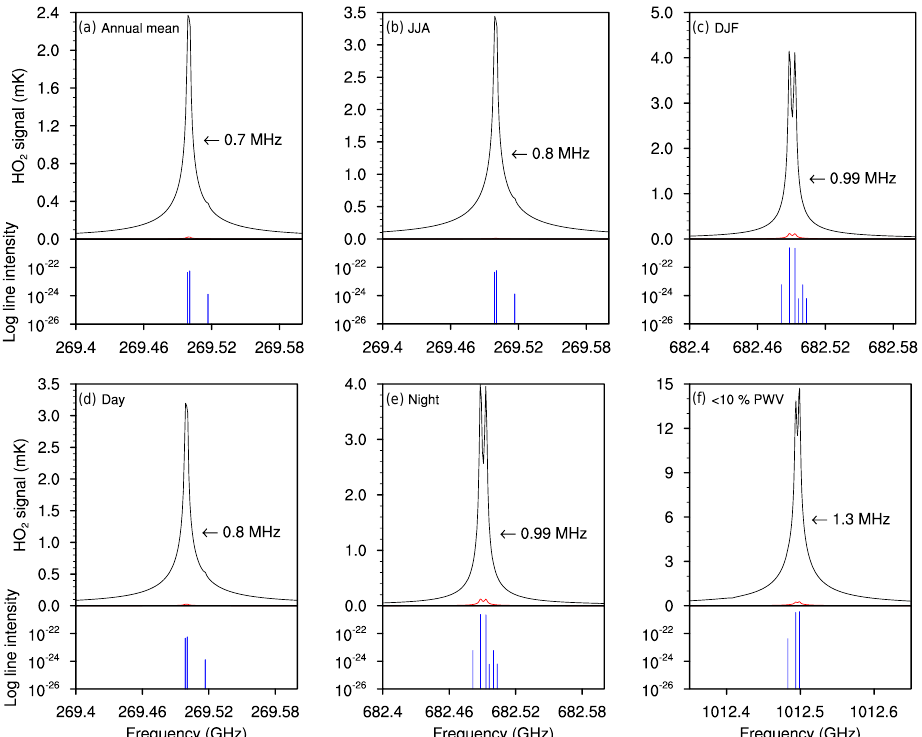
Figure 12. Same as Fig. 10 but for HO 2